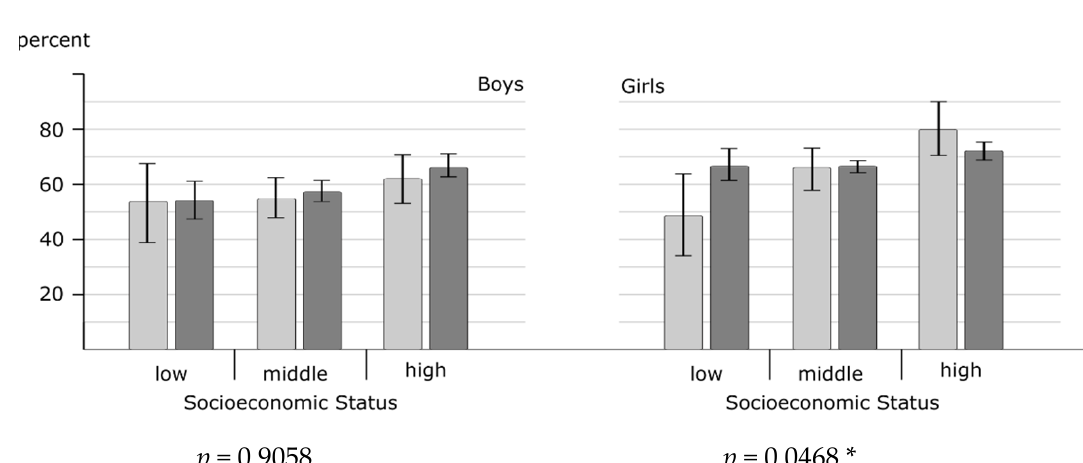
Figure 2. Predicted probabilities for sleep difficulties according to meeting the recommended physical activity level and socioeconomic status, stratified by sex. Results of logistic regression models with interaction terms of physical activity and socioeconomic status: adjusted for age, screen time, emotional and behavioral problems, and personal resources. p values calculated with the Wald-test; * p < 0.05. ( a ) Unrecommended sleep duration; ( b ) Sleep-onset difficulties; ( c ) Trouble sleeping; ( d ) Daytime sleepiness.